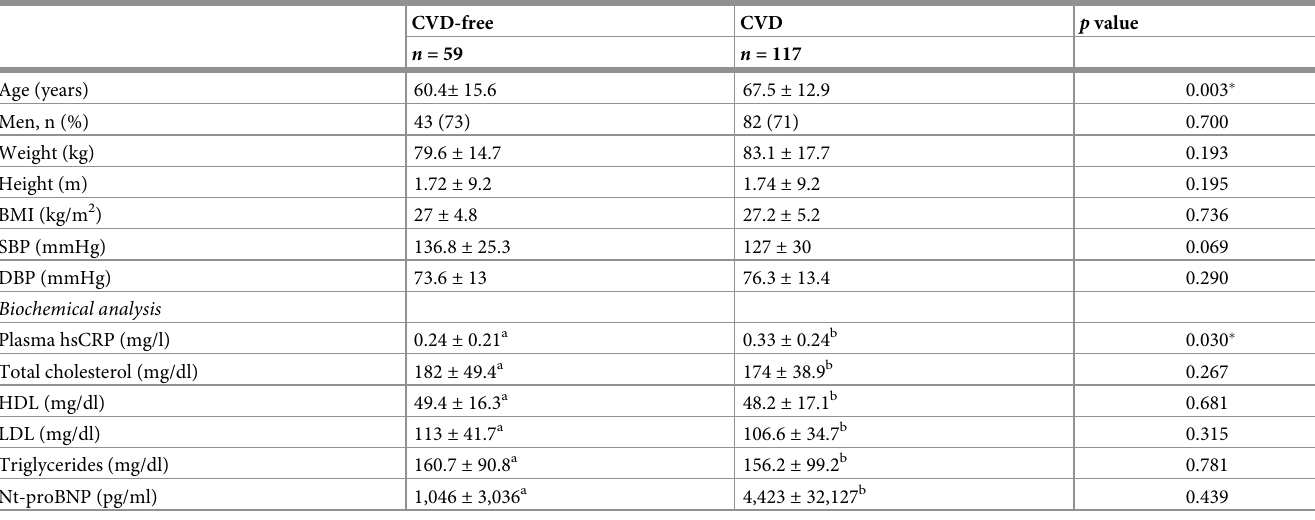
Table 1. Study subject